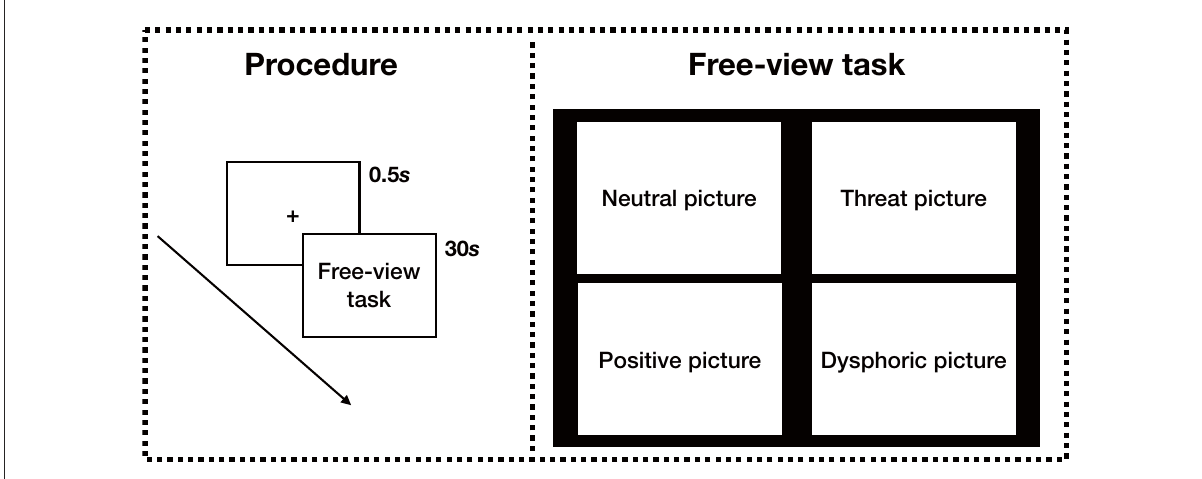
FIGURE1 Eye-tracking experiment procedure and free-viewing task demonstration.